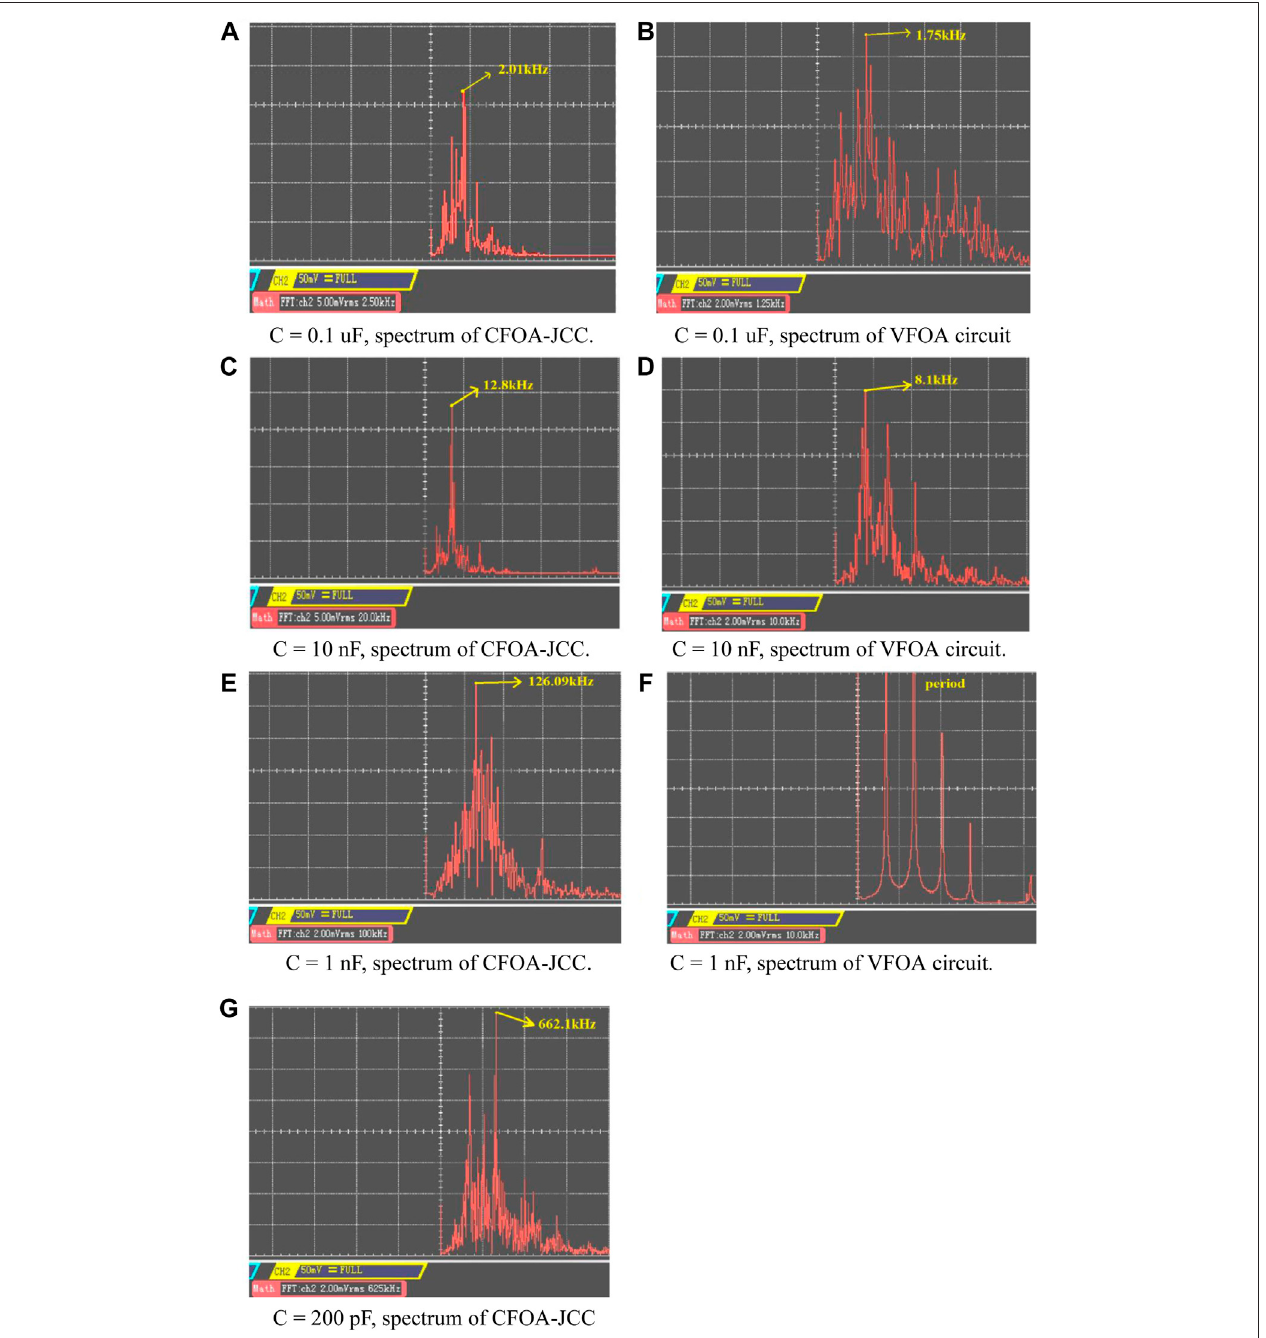
FIGURE 11 | Spectrums of the CFOA-JCC and VFOA circuit when capacitors take different values. (A) C = 0.1 uF, spectrum of CFOA-JCC. (B) C = 0.1 uF, spectrumofVFOAcircuit. (C) C=10nF,spectrumofCFOA-JCC. (D) C=10nF,spectrumofVFOAcircuit. (E) C=1nF,spectrumofCFOA-JCC. (F) C=1nF,spectrum of VFOA circuit. (G) C = 200 pF, spectrum of CFOA-JCC